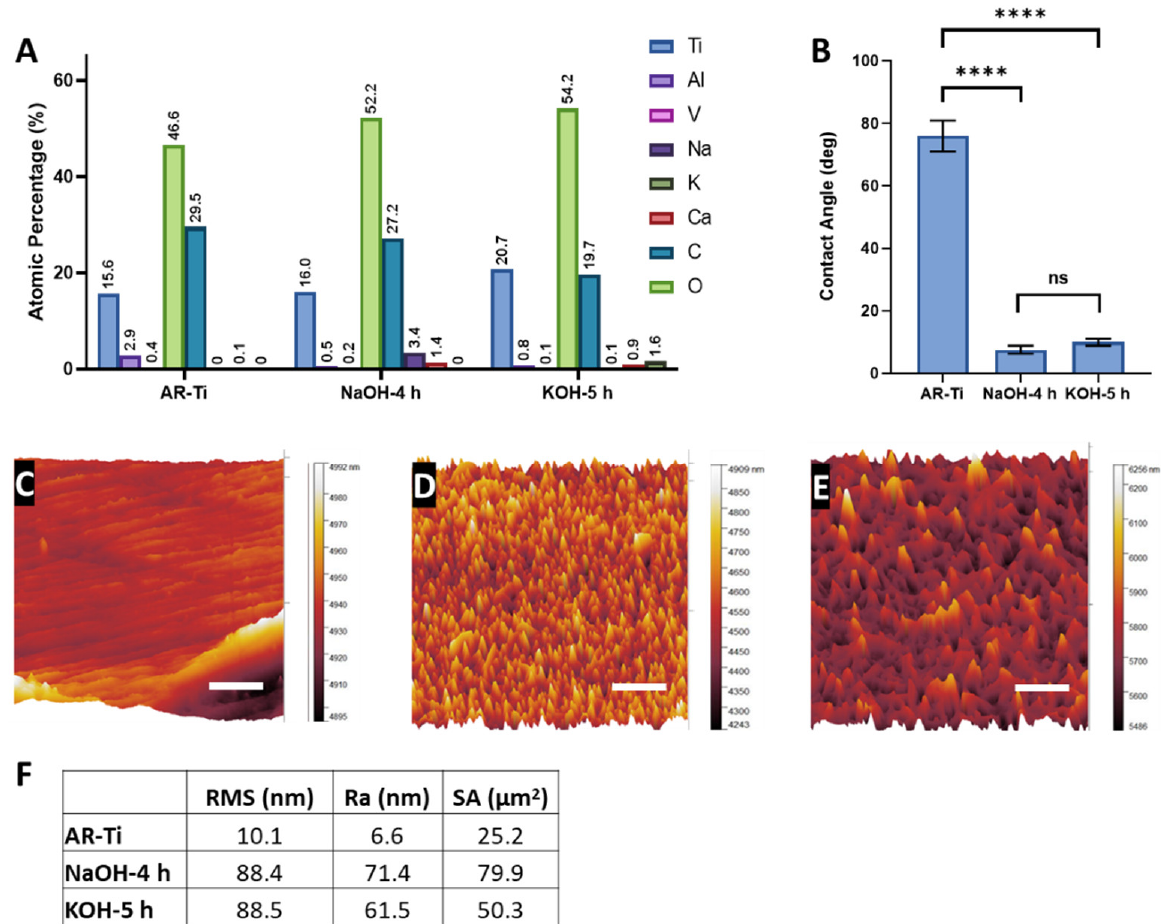
Figure 8. Surface analysis of NaOH-4h and KOH-5h, by XPS survey spectra ( A ), surface wettability